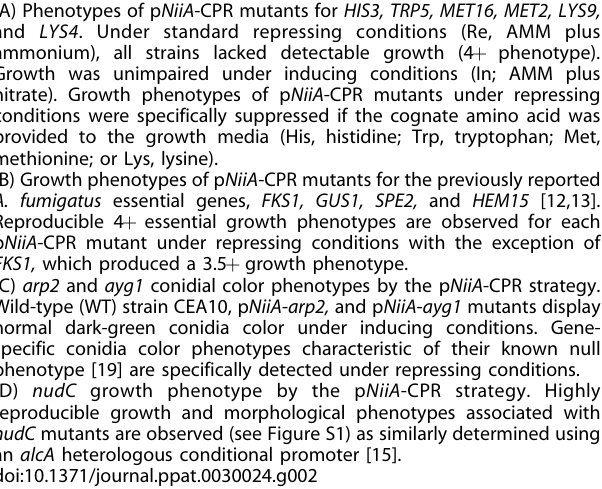
Figure 2. Genetic Evaluation of the p NiiA -CPR Strategy